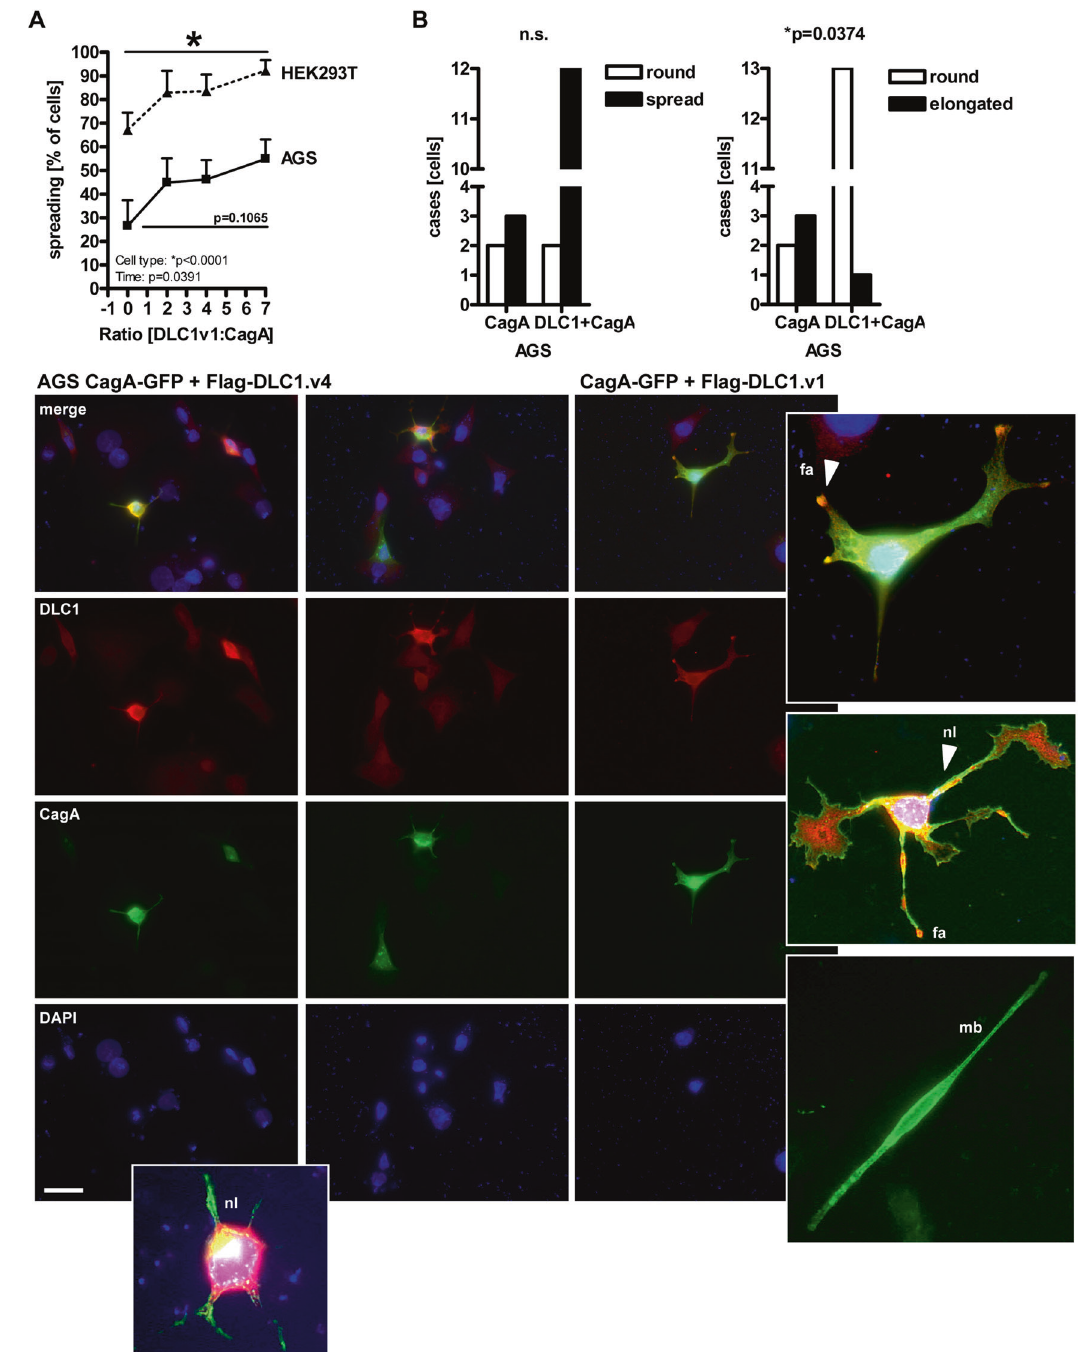
Fig. 4 DLC1 counteracts cell elongating ( “ humming bird ” ) by CagA. Cells (AGS, HEK293T) were transfected with EV, CagA, or DLC1 expression plasmids or a combination thereof for 36 h, followed by fi xation and staining using DLC1 and FLAG Abs for immuno fl uorescence microscopy. Quantitative analyses (top) and representative images (bottom). Numbers of adherent cells with morphologies (spread-out, round, elongated) were counted, normalised to total cell counts and calculated as % ± S.E. ( A , HEK293T: * p < 0.05 vs. EV ( t = 0), 2way-ANOVA Bonferroni post-tests, n = 3 per cell line; B AGS: * p = 0.0374, Fisher-Exact test; n = 3). Colour code: Red = DLC1; Green = CagA (GFP); Yellow = DLC1/CagA (overlay); Blue = nuclei (DAPI); Original magni fi cations ×400 (zoomed-in 630×); Scale bar = 20 µm. White frames/arrows: DLC1 promotes neurite-like extensions (abbrev. “ nl ” ) (DLC1v4 + ) or localises to focal adhesions (abbrev. “ fa ” ) (DLC1v1 + ); membrane-bound (abbrev. “ mb ” ) CagA forms needle-like elongations ( “ humming bird ” DNA-constructs The ~1kb fragment of the proximal human DLC1v1 (NC_018919.2; position 135.59.304 – 135.60.451) promoter [7] was ampli fi ed by PCR from genomic and Baden-Württemberg (55.2-1-54-2531-74-08/-99-10; -2532-155-12; 35- DNA of normal human liver and inserted into the KpnI/SacI sites of 9185.81/G-146/15; 55.2-1-55-2532-196-2016).